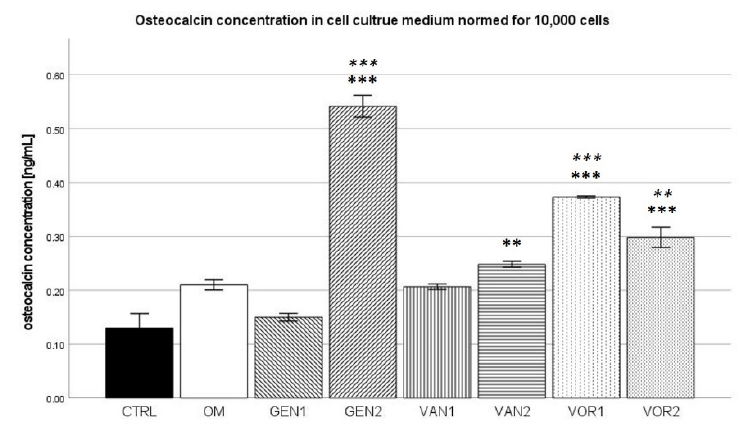
Figure 7. Mean osteocalcin concentration per group as measured in the cell culture medium, normed for 10,000 cells. The error bars show the error of mean. Significances are indicated by stars: bold stars indicate a significance compared to the negative control CTRL, stars in italics indicate a significance compare to the osteogenic control OM. ** = significance p ≤ 0.01, *** = significance p ≤ 0.001.